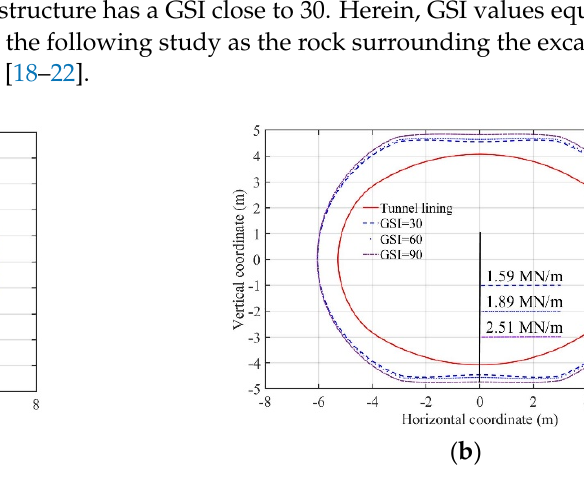
Figure 7. Distributions of internal forces of lining under different GSI. ( a ) Bending moments M ; ( b ) Normal forces N . ( b ) Normal forces N